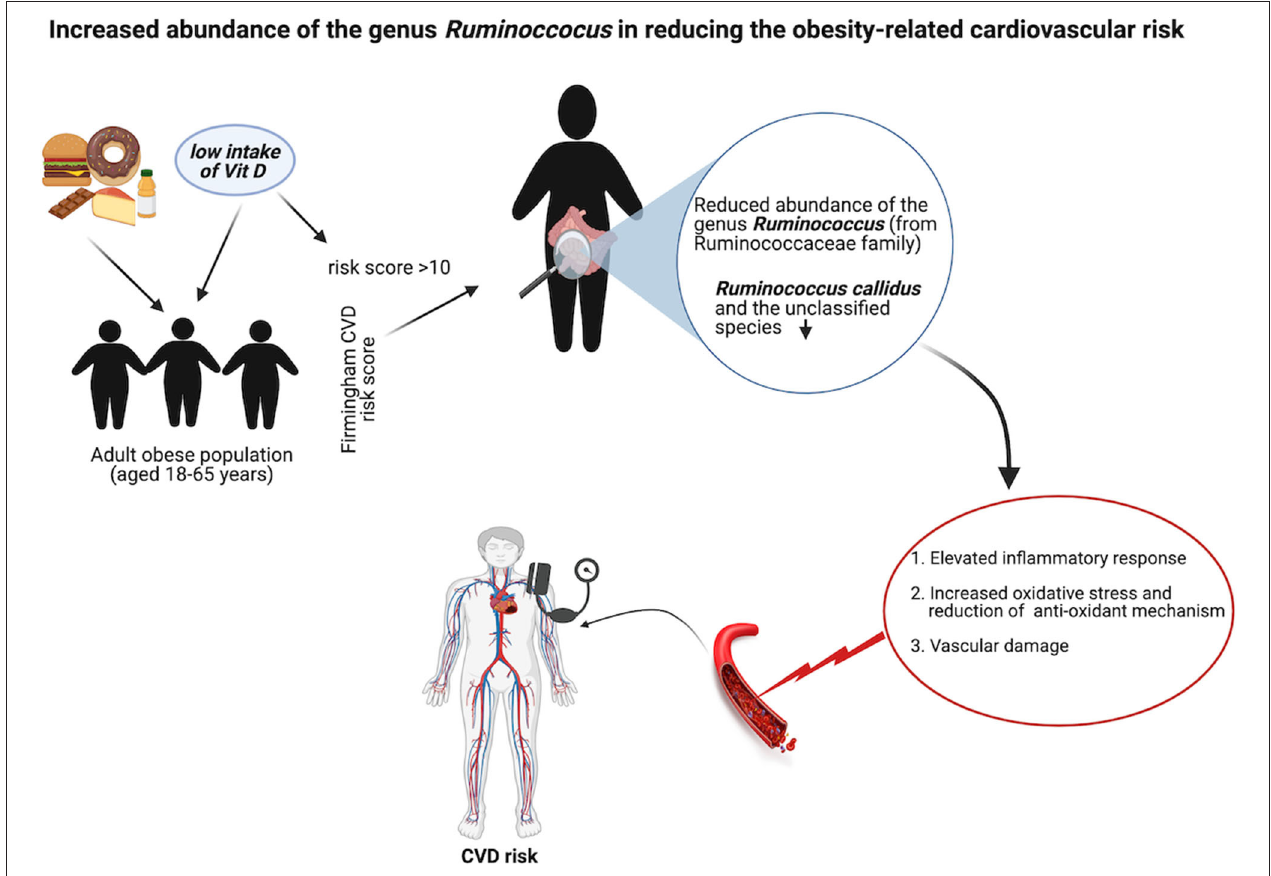
FIGURE 7 | Schematic representation of the role of Ruminococcus in obese-related CVD. Created with